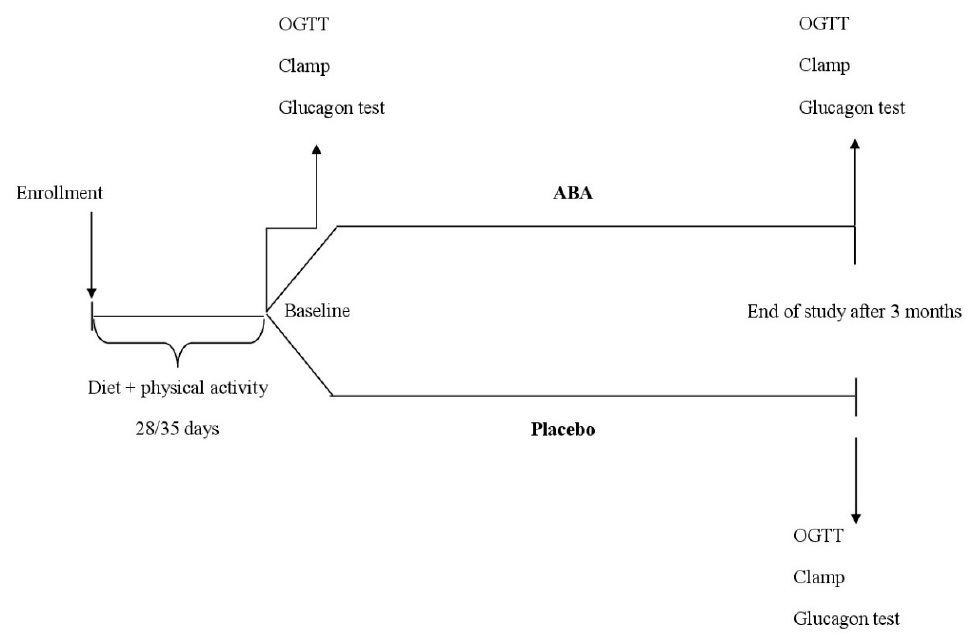
Figure 1. Study design. OGTT: oral glucose tolerance test; Clamp: euglycemic hyperinsulinemic clamp; ABA: abscisic acid. Table 1. Baseline, and 3-month general data of patients during abscisic acid (ABA) treatment and placebo. Parameters